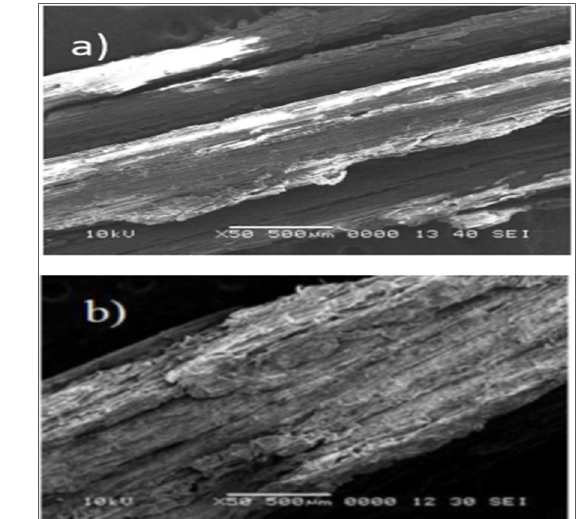
Fig. 3: SEM micrographs of; a) Untreated bagasse fibers and b) Treated bagasse